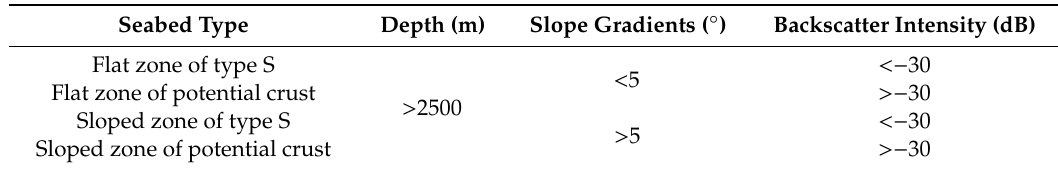
Figure 11. Spatial distribution map of Fe–Mn crust occurrences combining backscatter data, multibeam bathymetry, and ground-truth validation in the ( a ) northwest, ( b ) northeast, ( c ) southwest, and ( d ) south sectors of Figure 1b. Table 1. Parameters used in mapping the spatial distribution of Fe–Mn crust occurrences in target’s Table 2. Accuracy of spatial distribution map of Fe–Mn crust occurrences. regions with the exception of OSM 15, 16, and 18.